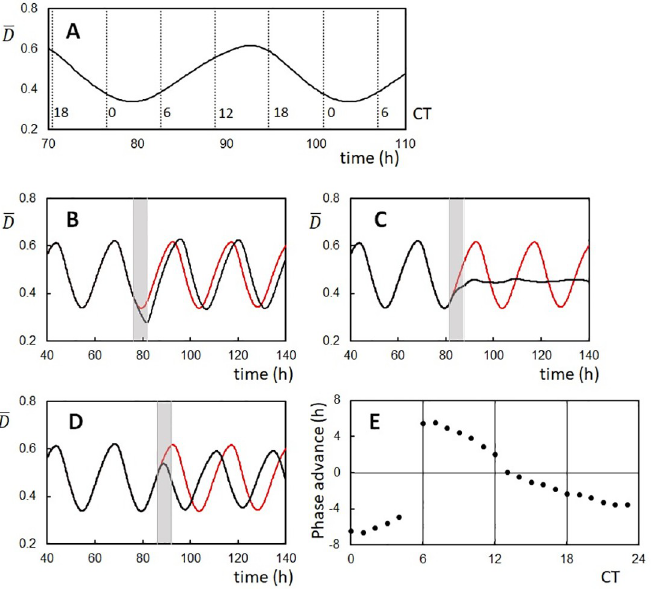
Fig 8. Phase shifts of the ensemble-averaged oscillations of the KaiC phosphorylation level caused by pulses of the ADP increase. ( A ) Circadian Time (CT) was set to be 16 at the peak of oscillations and the period was normalized to be 24 h in CT. Time denoted on the x -axis is the simulated incubation time (IT). ( B ) An example trajectory showing the phase delay by adding an ADP pulse from CT 0 to CT 6 (gray bar from IT 76 to IT 82). ( C ) An example trajectory showing the desynchronization by adding an ADP pulse from CT 5 to CT 11 (gray bar from IT 81.6 to IT 87.6). ( D ) An example trajectory showing the phase advance by adding an ADP pulse from CT 9.5 to CT 15.5 (gray bar from IT 86 to IT 92). In B , C , and D , the oscillation trajectory perturbed by an ADP pulse (black) and the trajectory without perturbation (red) are superposed. ( E ) PRC plotted as a function of CT when the ADP pulse started to be added. During the ADP pulse, D 0 was increase to 4 D 0 . T = T 0 and N = ADP ADP